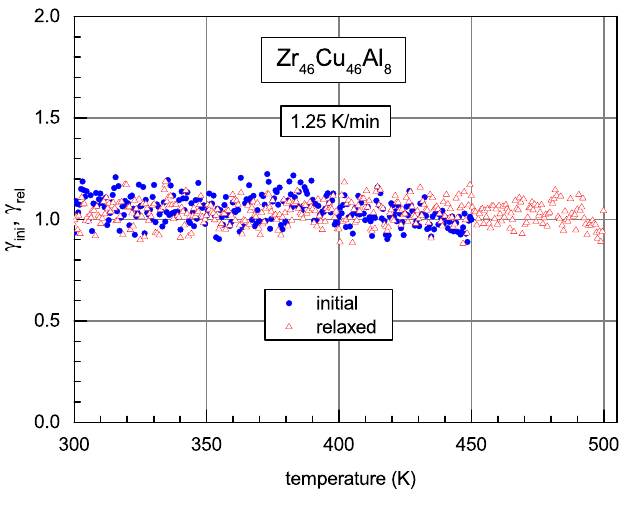
Figure 8. Ratios of the temperature coefficients of the shear moduli in glassy (initial and relaxed) and crystalline states of Zr structural relaxation is absent (see Figure 7). Temperature-independent (cid:13) confirm Equation